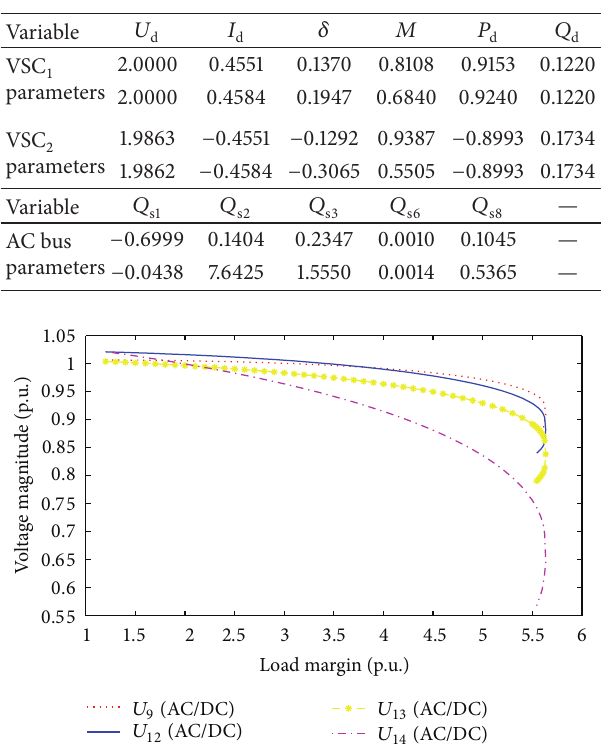
includes the four PV buses (bus 2, bus 3, bus 6, and bus 8) and a slack bus (bus 1) of the modified IEEE-14 test system. The upper row of the twin-row is the initial state data, and the lower row of the twin-row is the maximum load state = 5.6358 p.u. in Figure 4) (corresponding with the 𝜆 AC / DC data of power